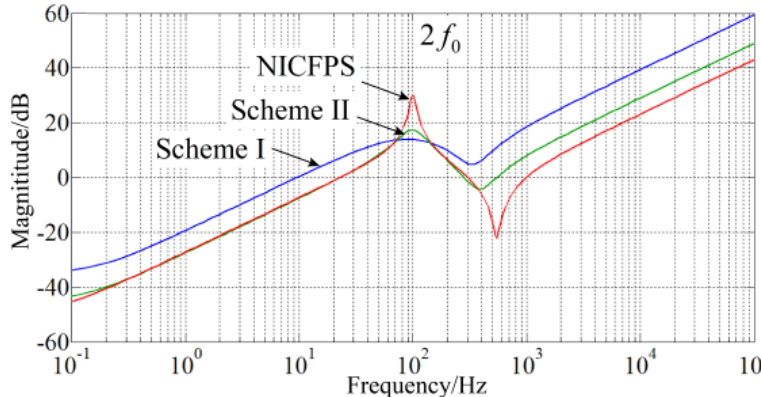
Figure 11. Magnitude plots of output